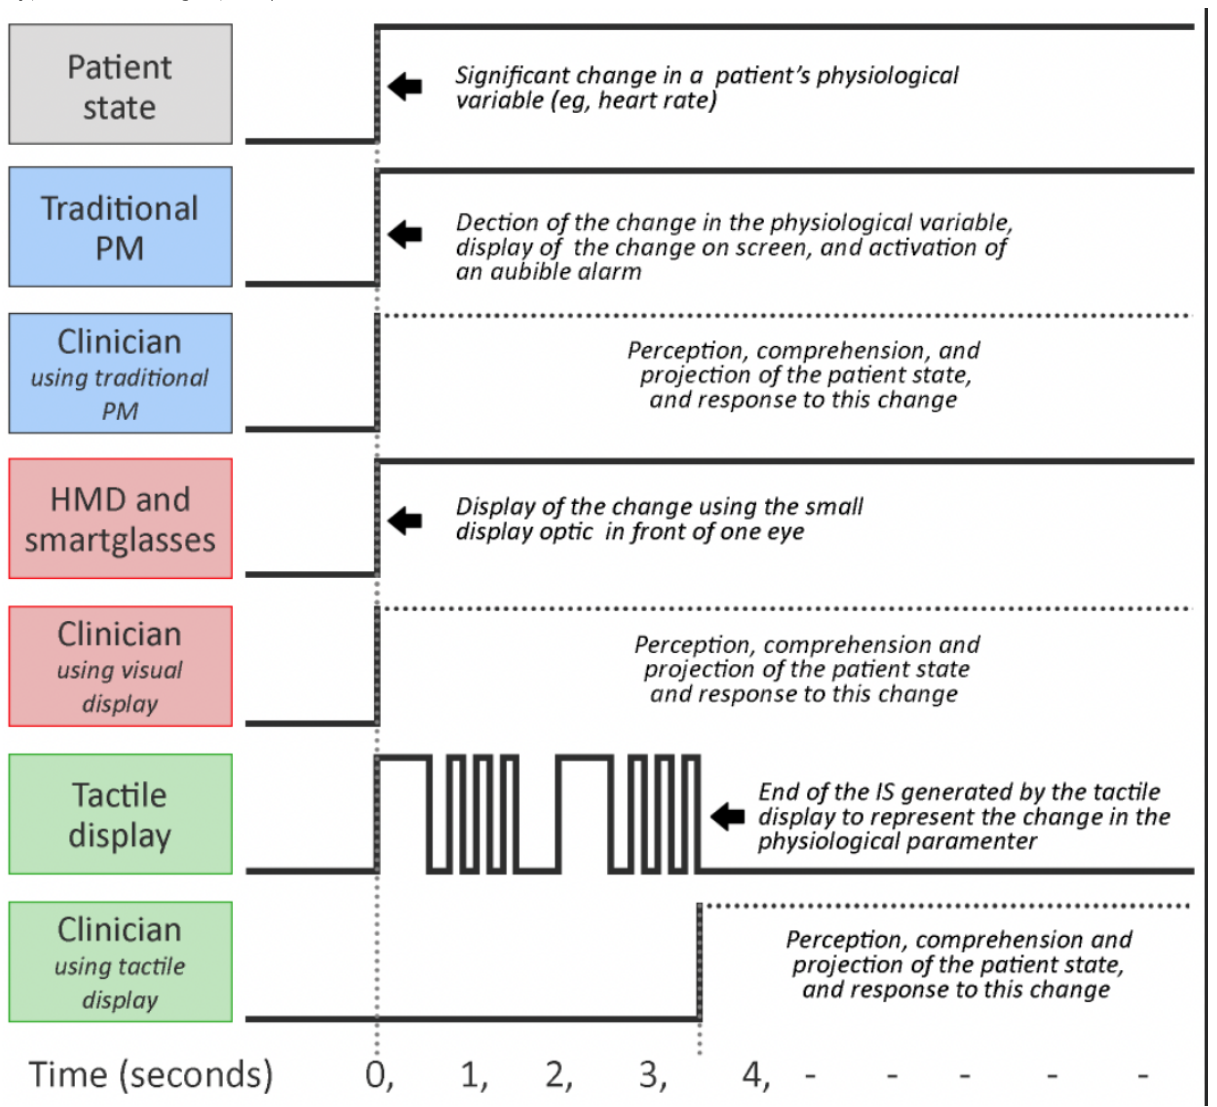
Figure 25. Timing diagram of patient state changes and clinician's response. With visual displays, the message is conveyed almost instantaneously. In contrast, in auditory and tactile displays, the message is conveyed through audio or vibration patterns, requiring more time to convey. HMD: head-mounted display; IS: interaction signal; PM: patient